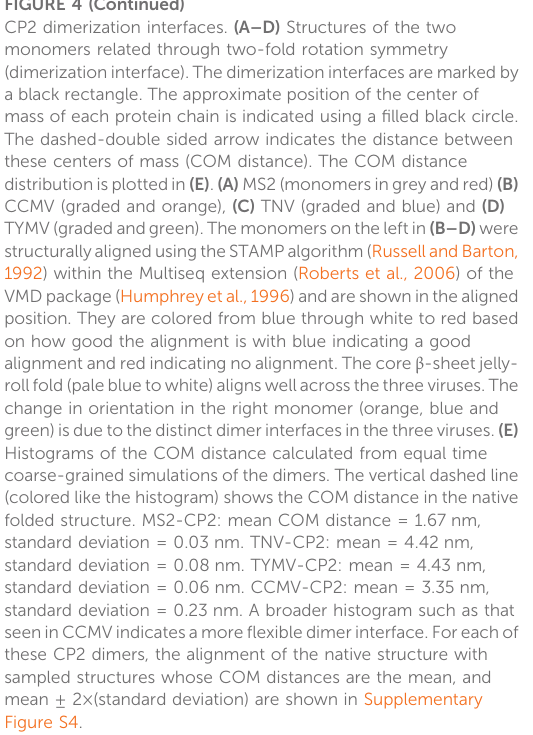
Tombusviridae : Tobacco Necrosis Virus: TNV (PDB ID: 1C8N); and Tymoviridae : Turnip Yellow Mosaic Virus: TYMV (PDB ID: 1AUY). For one monomer from each of the CP2s, we performed a multiple structure alignment using the STAMP algorithm (Russell and Barton, 1992) as implemented in the Multiseq extension (Roberts et al., 2006) of the VMD package (Humphrey et al., 1996). The aligned CPs (Figures 4B – D left chains) were colored based on their alignment from blue through white to red, with well-aligned regions in blue and unaligned regions in red. The second chains (Figures 4B – D right chains) of the dimers were not aligned. These jelly-roll CP2s and the MS2- CP2 (also extracted from the bacteriophage MS2 tri-dimer; PDB ID: 2MS2, Figure 4A) were used to understand dimer dynamics.